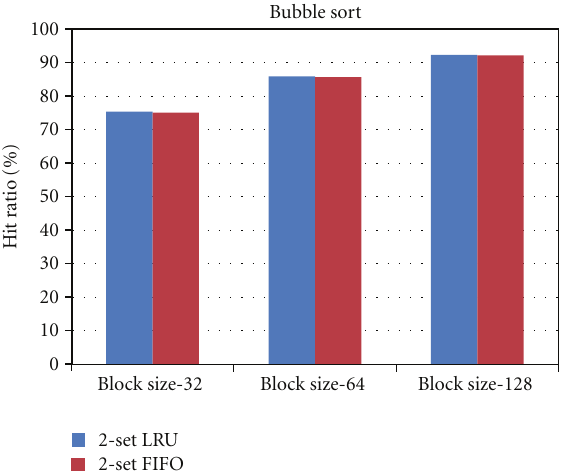
Figure 12: Hit ratio of replacement policy comparison—bubble sort. Table 1: Experimental